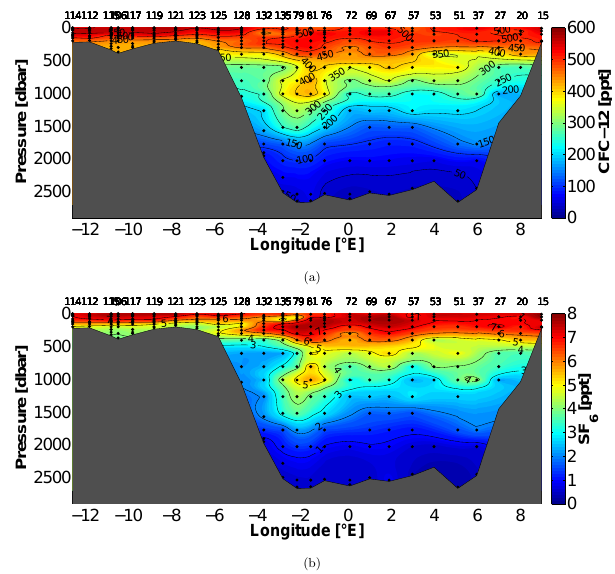
Figure 1 Figure 3. Distribution of the partial pressure of (a) CFC-12 and (b) SF 6 along the zonal section in the Fram